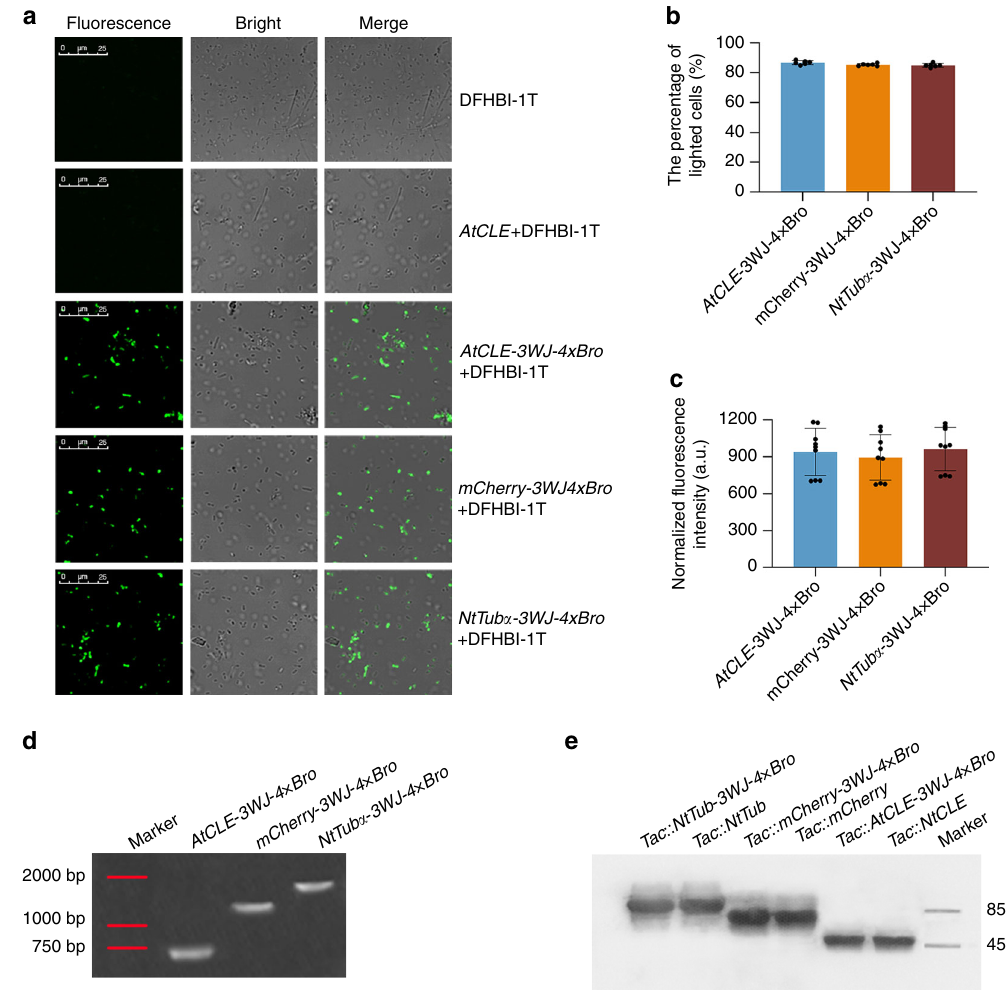
Fig. 4 Performance of 3WJ-4 × Bro in E. coli cells for reporting the expression of various genes. a Representative images of E. coli cells expressing three mRNAs tagged with 3WJ-4 × Bro after incubation with 10 μ M DFHBI-1T. Scale bars, 25 μ m. b The percentage of detectable fl uorescing cells to the 500 total cells expressing each 3WJ-4 × Bro-tagged mRNAs. Error bars, mean ± s.d. ( n = 6). c Fluorescence quanti fi cation of mRNAs tagged with 3WJ-4 × Bro in cells. Error bars, mean ± s.d. ( n = 9). d Assessment of the integrity of three mRNAs with the 3WJ-4 × Bro tag in E. coli cells. Total cellular RNA was extracted and separated by urea denaturing gel electrophoresis. After washing, the gel image was stained with DFHBI-1T and photographed. Red lines indicate the locations of marker bands on the gel. e Immunoblot analysis of target proteins translated from 3WJ-4 × Bro-tagged mRNAs. Source data are provided as a Source Data Underlying e . All experiments were repeated three independent times with the same conclusion. Source Data are provided as a Source Data fi